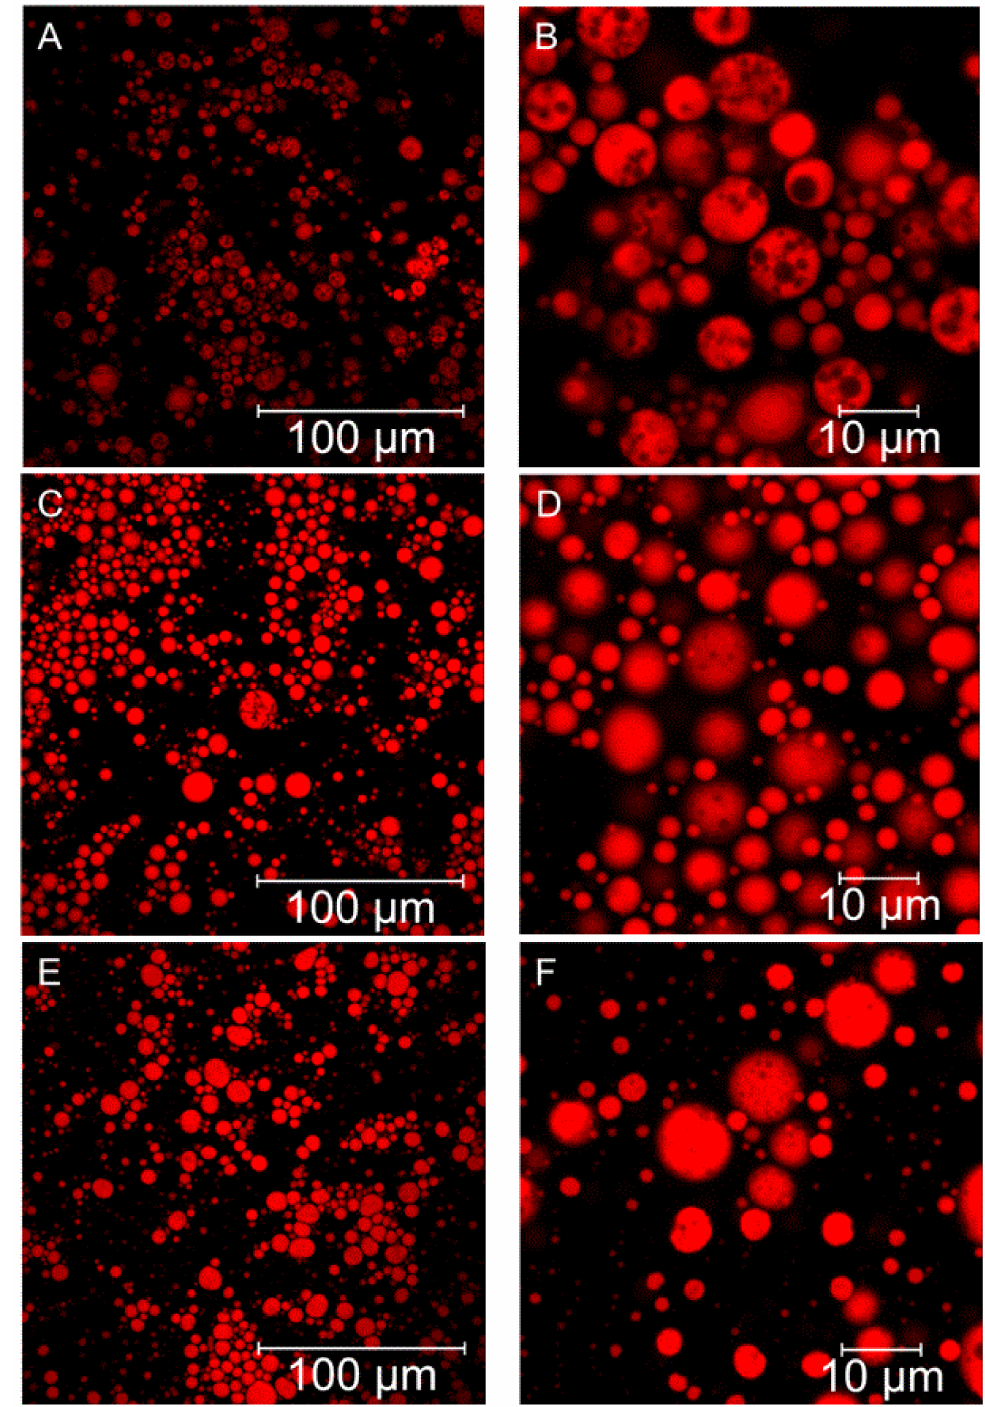
Figure 1. Confocal laser scanning micrographs of a W 1 /O/W 2 emulsion with an amidated pectin- gelled W 1 phase, 0.1 M citrate buffer as the background electrolyte, and an oil phase dyed with Nile red. Images of the emulsion on day 1 (Panel ( A , B )), day 2 (Panels ( C , D )), and day 5 (Panels ( E , F )) are shown. Panels ( B , D , F ) are magnified images from the same sample as that of Panels ( A , C , E ),